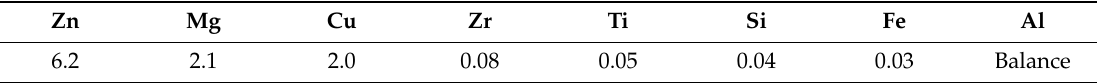
Table 1. Chemical composition (wt%) of 7B50-T7751 aluminum